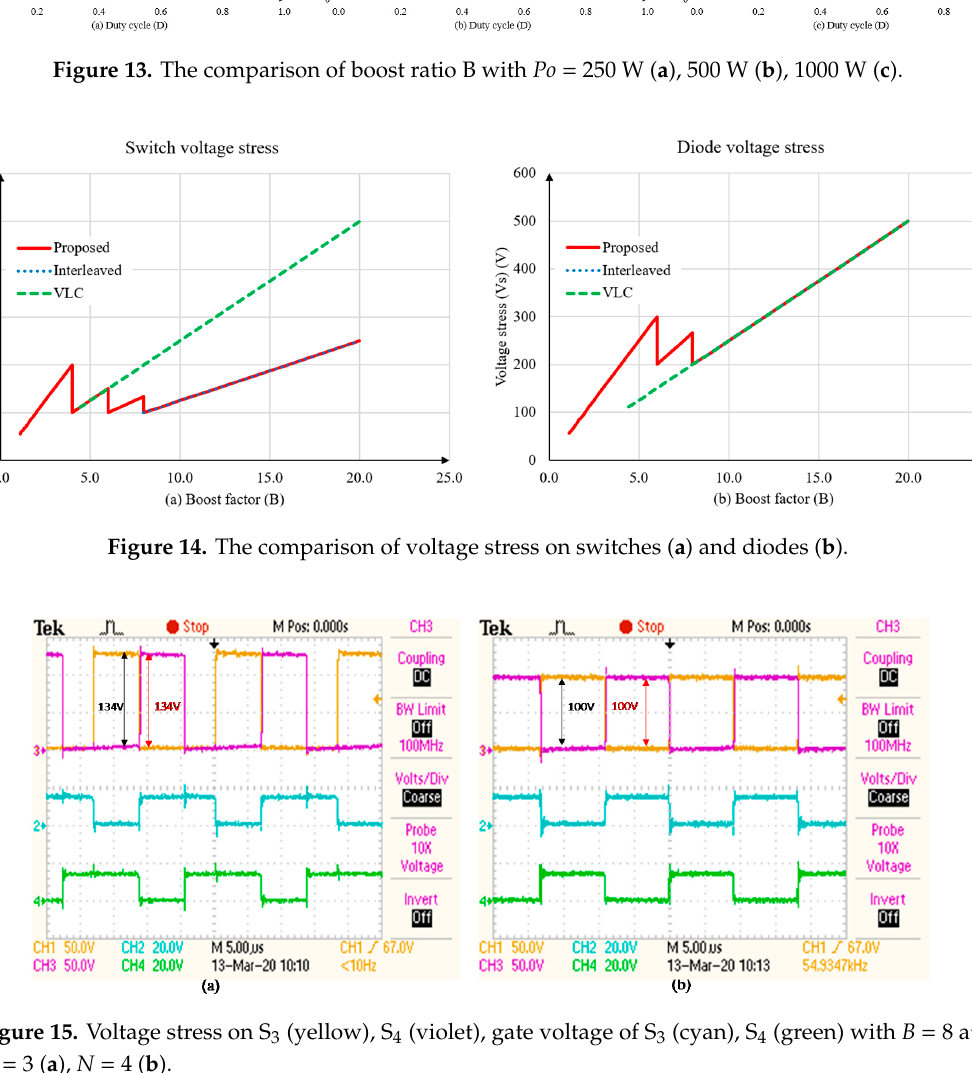
Figure 15. Voltage stress on S 3 (yellow), S 4 (violet), gate voltage of S 3 (cyan), S 4 (green) with B = 8 at N = 3 ( a ), N = 4 ( b ).